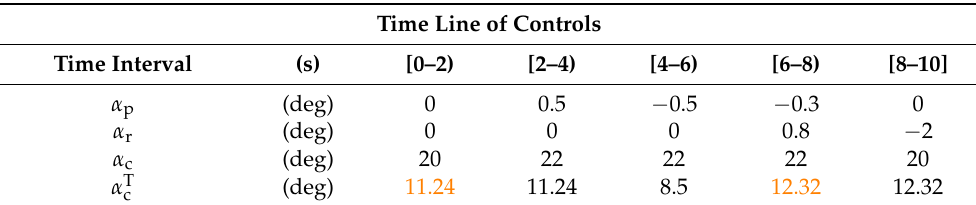
Table 5. Eighth test—free flight. The orange-colored values indicate that the no-yaw flight mode has been activated in that time